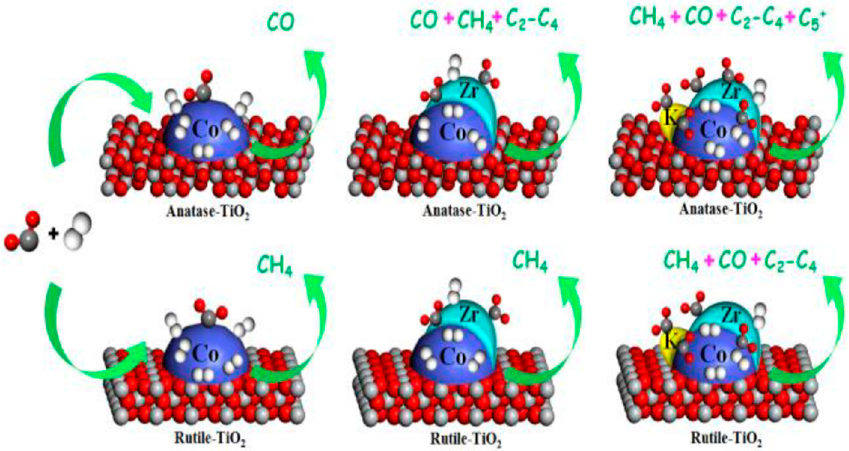
Scheme 5. Schematic illustration of CO 2 hydrogenation over unpromoted and Zr- and